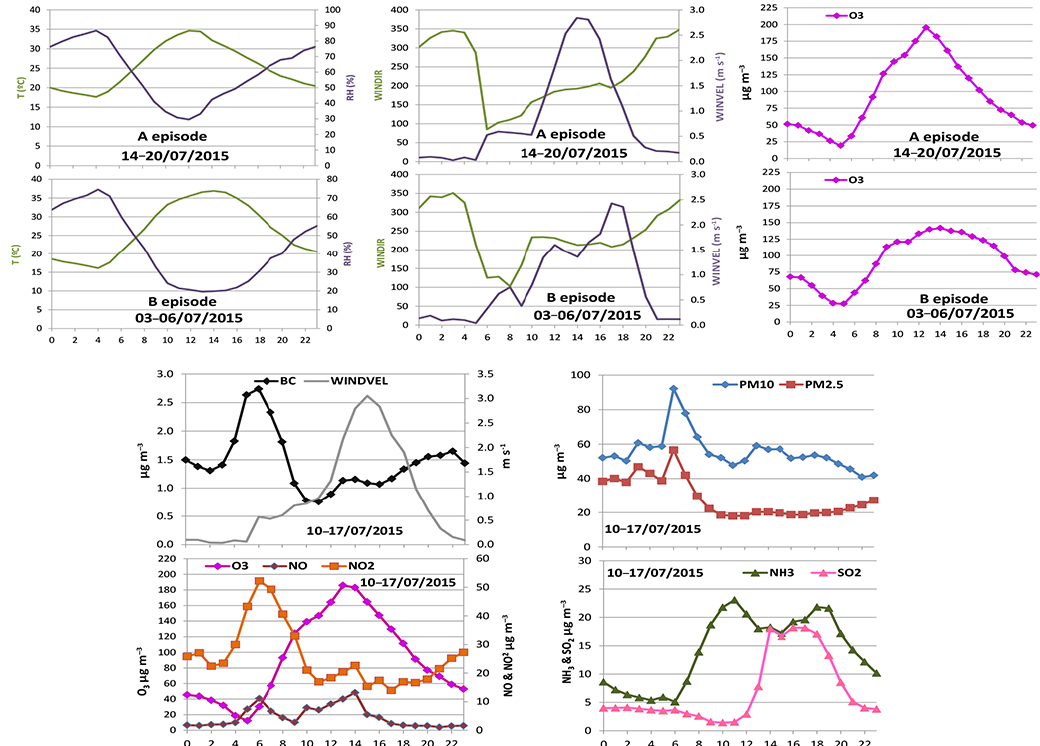
Figure 4. Top: mean hourly (UTC) values for meteorological parameters and O 3 ambient air concentrations measured during the periods 3–6, 14–20 and 10–17 July 2015 recorded at the permanent VIC XVPCA station (O 3 ) and at the Gurb meteorological station (temperature, humidity and wind patterns, Meteocat) located 1km to the north of VIC. Bottom: mean hourly concentrations of other gaseous and particulate pollutants measured at VIC with the laboratory van (only during the period 10–17 July 2015) co-located with the XVPCA